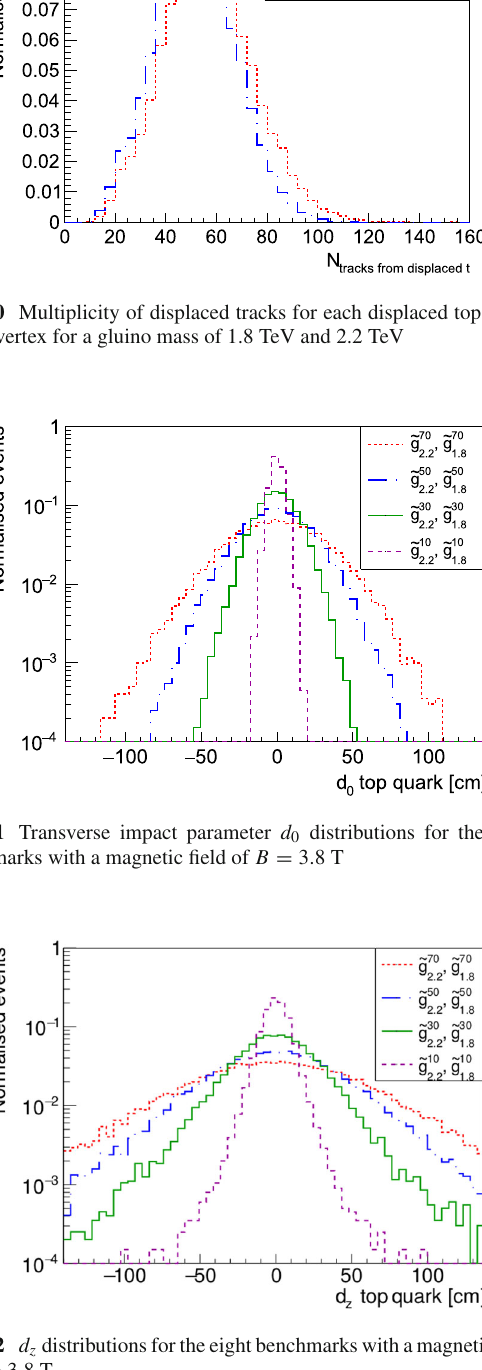
by the trigger system of the ATLAS and CMS multipurpose detectors, the other will be devoted to the offline selection achieved on the